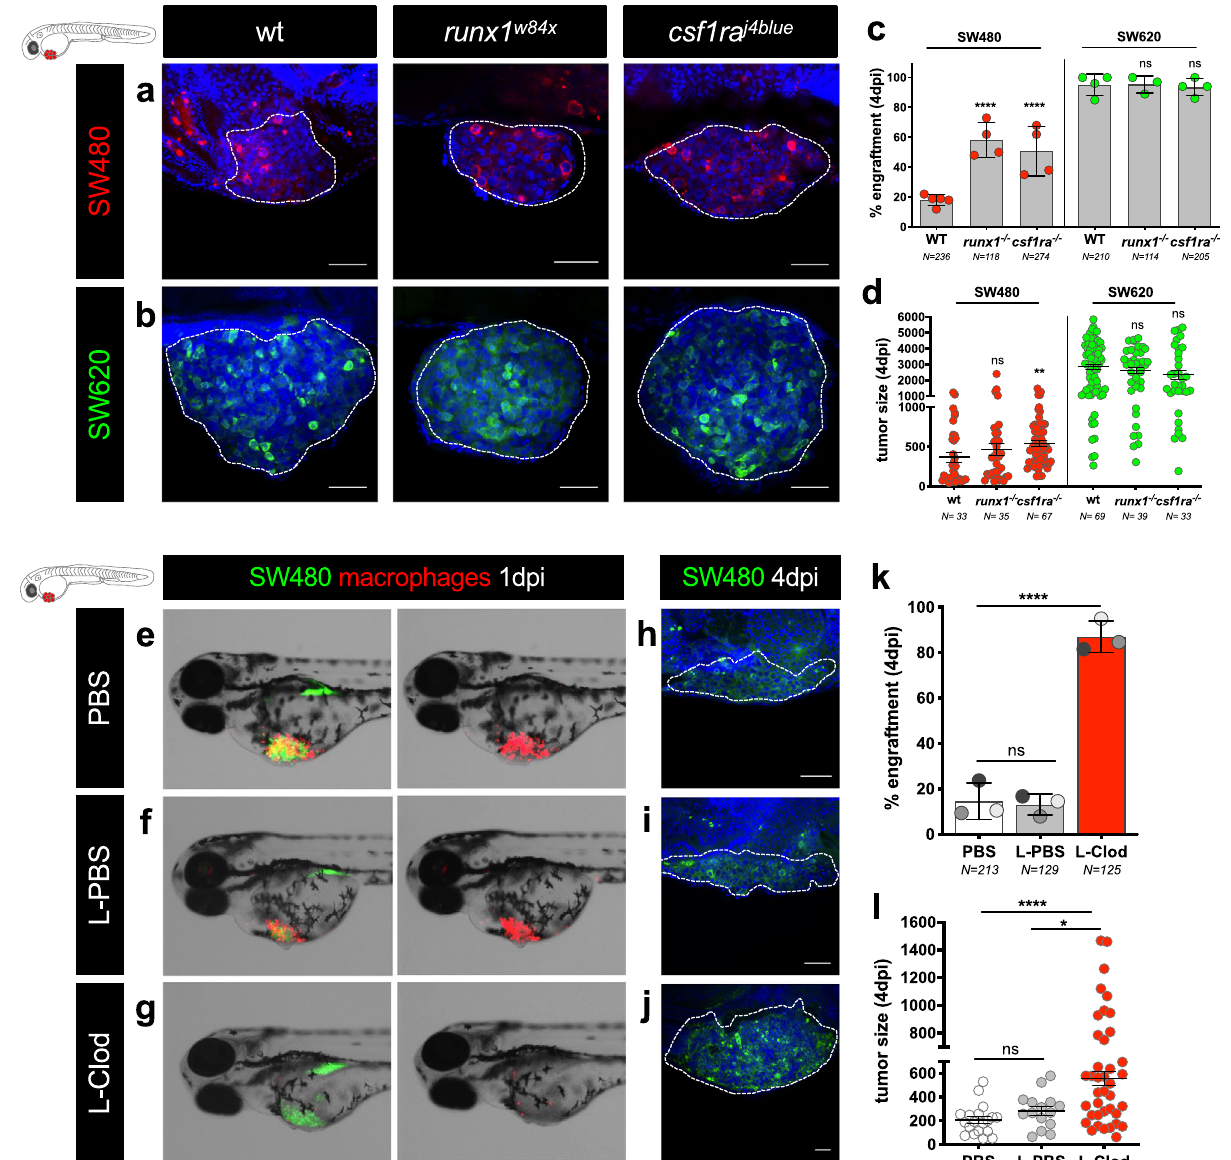
Fig. 5 Zebra fi sh innate immune cells regulate clearance of SW480 tumor cells. a , b Representative confocal images of SW480 and SW620 xenografts in runx1 w84x and csf1ra j4blue ( panther ) mutants. SW480 were labeled in red and SW620 in green. c Quanti fi cation of engraftment in runx1 w84x and csf1ra j4blue ( panther ) mutants and respective controls (Fisher exact test, **** P < 0.0001, SW620 wt vs SW620 runx1 w84x ns = 0.62, SW620 wt vs SW620 panther ns = 0.09). Error bars represent mean ± S.D. Each dot represents one independent experiment. d Quanti fi cation of tumor size in runx1 w84x and csf1ra j4blue ( panther ) mutants and respective controls (unpaired two-sided Mann – Whitney test — SW480 wt vs SW480 runx1 w84x ns = 0.22, ** P = 0.0013, SW620 wt vs SW620 runx1 w84x ns = 0.44, SW620 wt vs SW620 panther ns = 0.18). Error bars represent mean ± SEM, each dot represents one xenograft from 3 independent experiments. e – j Zebra fi sh embryos with 2 dpf were injected simultaneously with SW480 tumor cells (in green) with PBS (control), with L-PBS or with L-Clodronate liposomes into Tg(mpeg1:mcherry) background (macrophages in red). e – g Representative fl uorescence stereoscope images of SW480 xenografts at 1dpi in the different conditions. h – j Representative confocal images of SW480 xenografts at 4dpi. k Quanti fi cation of engraftment: Fisher exact test ns = 0.83, **** P <0.0001; error bars represent mean±S.D.; each dot represents one independent experiment, and each set of independent experiment is represented in a different gray color. l Quanti fi cation of tumor size — no. of tumor cells (unpaired two-sided Mann – Whitney test ns = 0.062, **** P <0.0001, * P = 0.022, error bars represent mean±SEM) in the different experimental conditions at 4dpi, each dot represents one xenograft from 3 independent experiments. Scale bars: 50 μ m. White dashed lines encircle tumor areas. Nuclei are stained with DAPI. N is depicted in the chart. See also Supplementary Fig. 6. Source data are provided as a Source data fi